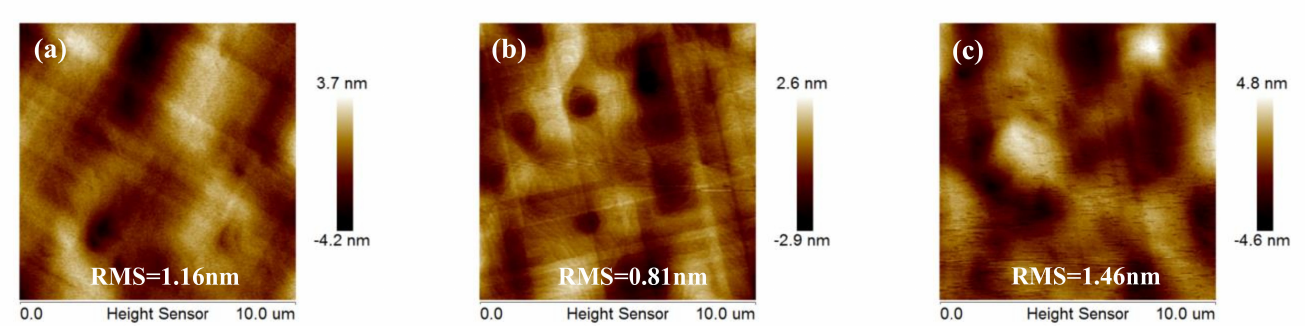
10 µ m 2 of Ge grown at different temperatures: ( a ) 550 ◦ C, ( b ) 650 ◦ C, ( c ) 750 ◦ C. The RMS Figure 9. AFM images 10 × roughness of the samples were 1.16, 0.81, and 1.46 nm,